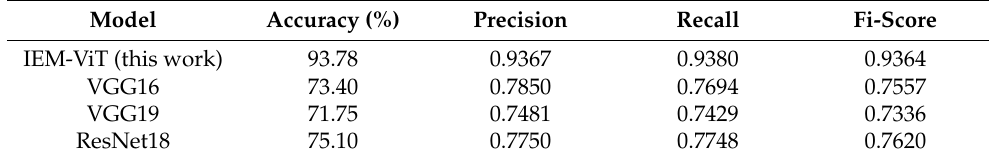
Table 2. Tea disease recognition results of different models.